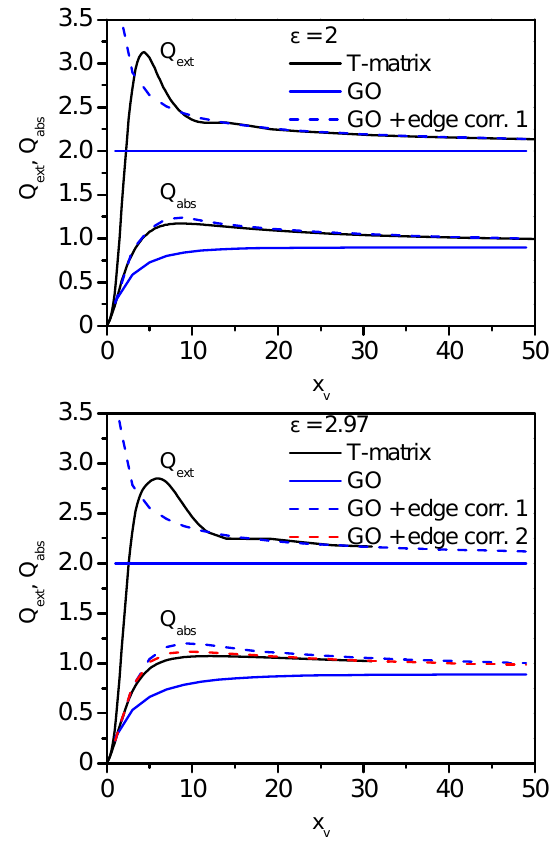
Fig. A1. Computed extinction, Q ext , and absorption, Q abs , efficien- cies for randomly oriented oblate spheroids with an aspect ratio, ε , of 2 (top panel) and 2.97 (bottom panel) as a function of the (equal- volume sphere) size parameter x v . The employed complex refrac- tive index was 1.5+0.1i. The black lines denote calculations with the T-matrix method and the blue lines computations with the ray tracing method including diffraction (GO: geometric optics). The dashed blue and red lines represent corrected geometric optics re- sults including an edge correction as outlined in the